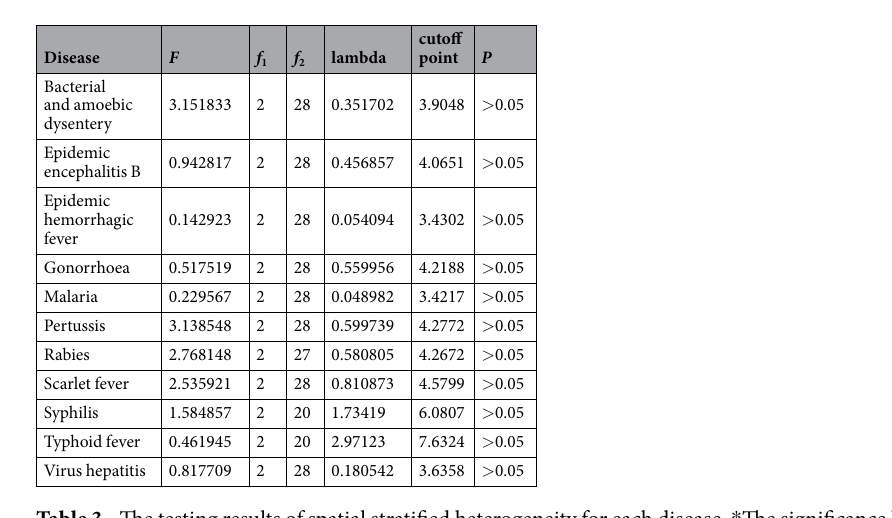
Table 3. The testing results of spatial stratified heterogeneity for each disease. * The significance level α was set to be 0.05 in advance. The F- statistics (column 2) was constructed based on the q -statistics, which followed a non-central F -distribution, with first and second degree of freedom f 1 (column 3) and f 2 (column 4), and noncentrality parameter lambda (column 5). Column 6 listed the 95% cutoff point, and by comparing it with the F statistics, it could be inferred whether P > α or not (column